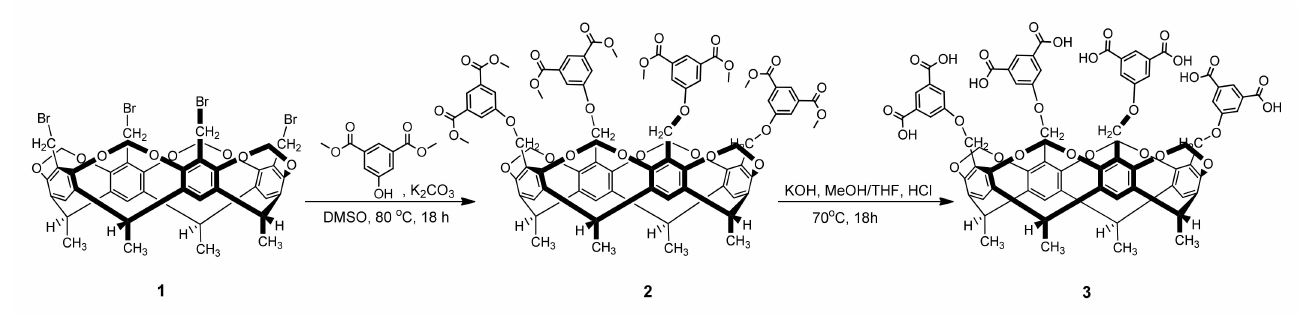
Figure 7. Schematic synthesis of TDC ( 3 ).